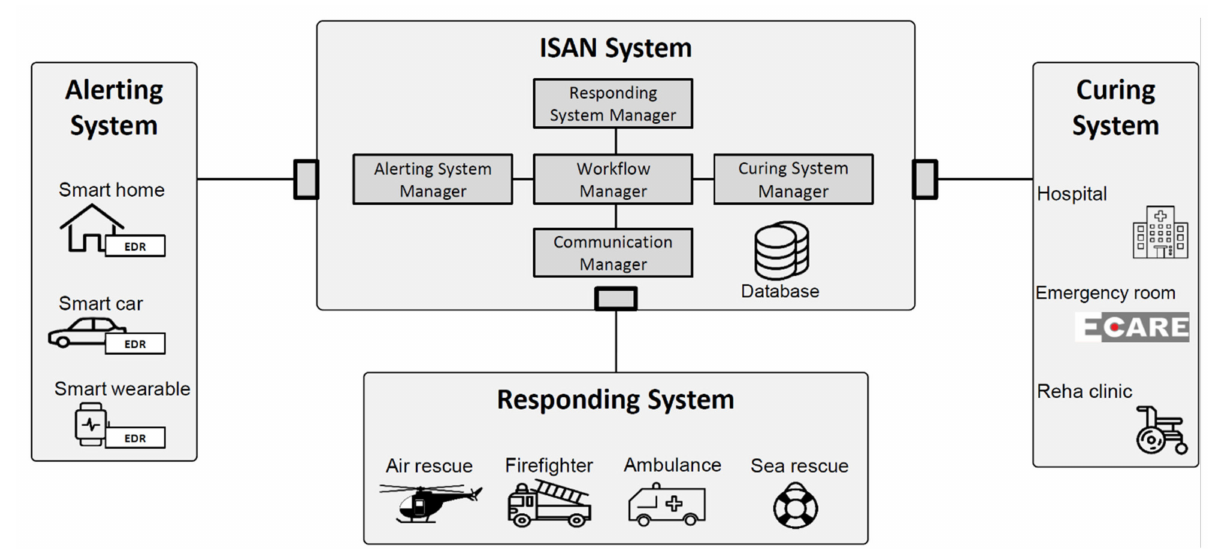
Figure 1. System architecture of the ISAN emergency communication platform. The ISAN system is triggered by an alerting system, handled by ASM, and specifies respective responding and curing systems by RSM and CSM, respectively. It manages the communication for data transfer by WFM and